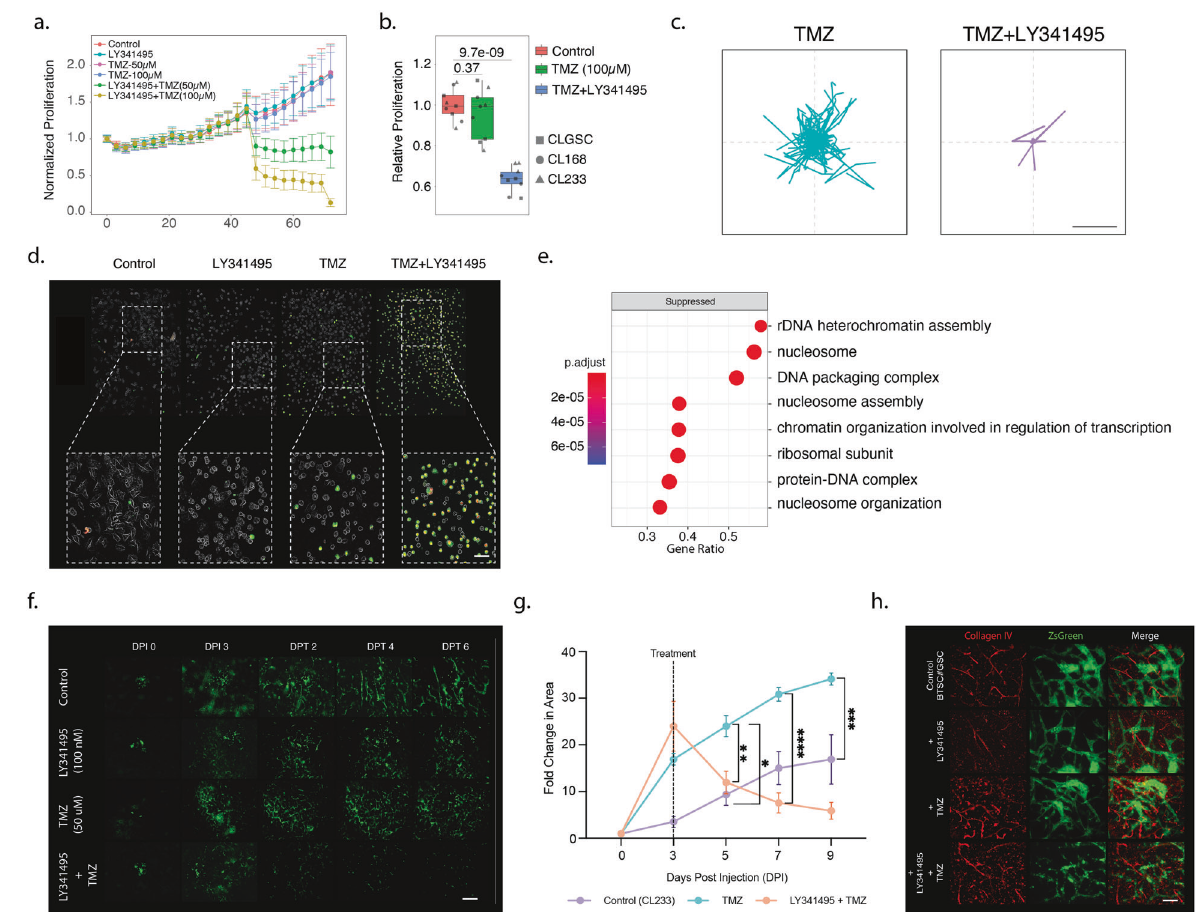
Fig. 5 Ef fi cacy of neo-adjuvant therapy with GRM3 inhibition in experimental conditions. With TMZ resistant cell lines ( a ) Quanti fi cation of time lapse imaging experiments show that TMZ alone had minimal effects of cellular proliferation. When combined with LY341495, there is a signi fi cant reduction in proliferation. The effect is potentiated when the dosage of TMZ is increased to 100 µM. b Relative proliferation measured by BrdU shows that there is no change in proliferation as a result of treatment with TMZ ( n = 3, p > 0.05), whereas there is a signi fi cant decrease in proliferation when cells were treated with the combined approach ( p < 0.0001). c Quanti fi cation of cellular migration shows that there is a signi fi cant reduction in cellular migration as a result of the combination therapy. d Kinetic apoptosis measurement. Cells in early apoptosis bind to pSIVA, showing green fl uorescence. When the cells are necrotic, PI is able to bind to the nuclear membrane, leading to red fl uorescence. Kinetic apoptosis assay shows that the combined treatment is the most effective in inducing terminal PI + cells within 4 h of treatment. The cells treated with the combination therapy appear yellow due to the expression of both pSIVA (green) and PI (red). Scale bar is 50 μ m. e Geneset enrichment analysis from samples treated with TMZ vs. TMZ + LY341495 ( f ) Growth pro fi les of GBM model sections under different treatment conditions. The combination treatment showed the most effectivity in reducing tumor growth. Scale bar is 250 μ m. g Quanti fi cation of tumor growth over time shows that there is a signi fi cant reduction in the tumor growth in the combined treatment strategy. There is no reduction in tumor growth in control sections and TMZ treated (50 µM) sections post treatment, whereas a strong reduction in tumor area is seen in the sections treated with the combination therapy. h Immunostainings of collagen within the injected slices show GBM cells growing along blood vessels in control, LY341495 and TMZ treated conditions. When the combination therapy was used, we see a strong decrease in the GBM cell growth. Scale bar is 50 μ m. The box plot represents median, with hinges representing 25th and 75th percentile and whiskers representing 1.5x Interquartile